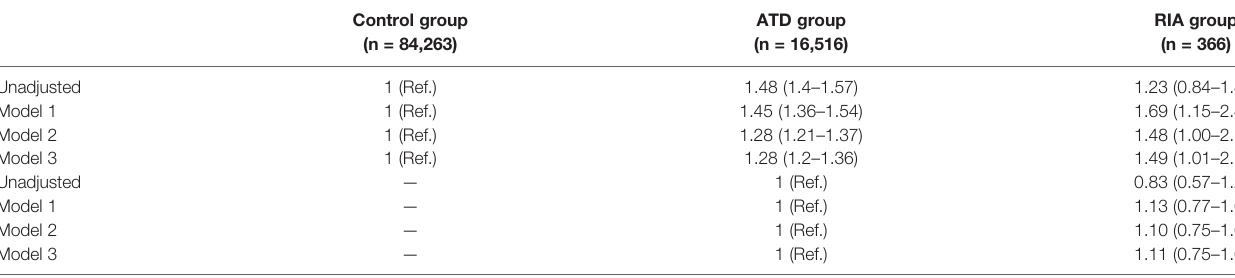
TABLE 2 | Hazard ratios and 95% con fi dence intervals for heart failure based on treatment modality. Control